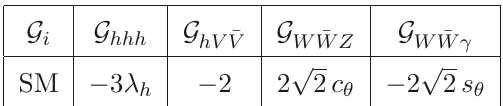
Table 3 . Map between the dimensionless